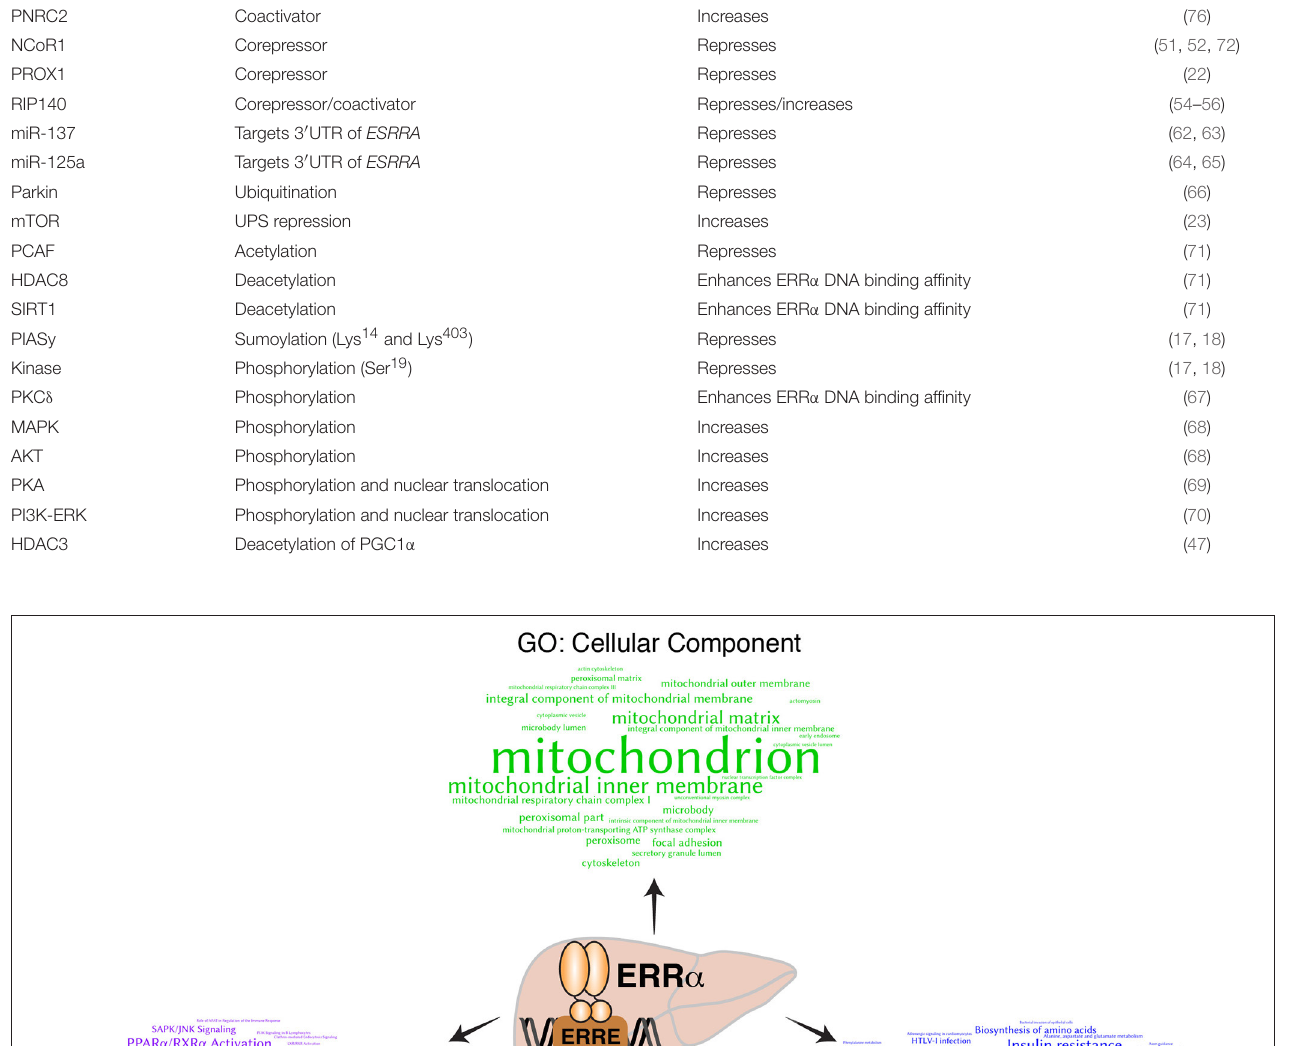
Frontiers in Endocrinology |